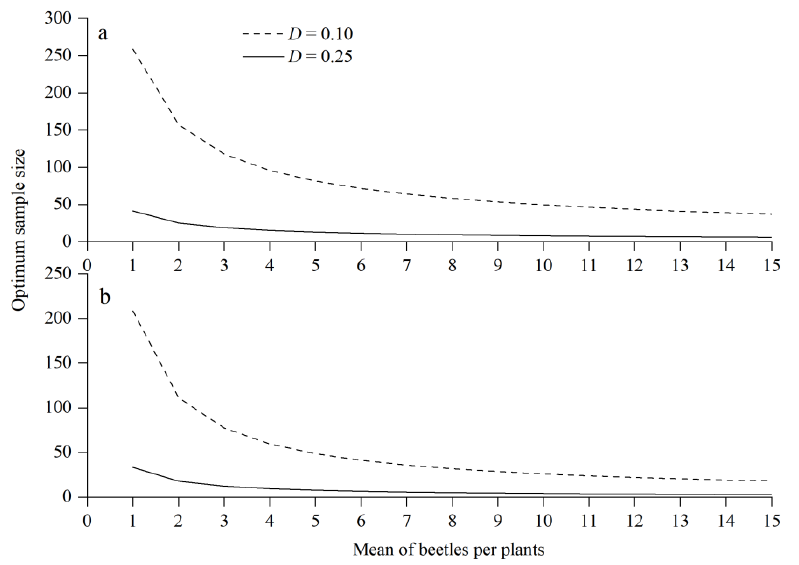
Figure 2. Optimum sample size of Tomicus minor ( a ) and Tomicus yunnanensis ( b ) in three Pinus yunnanensis tree sizes at precision levels of 0.1 and 0.25.